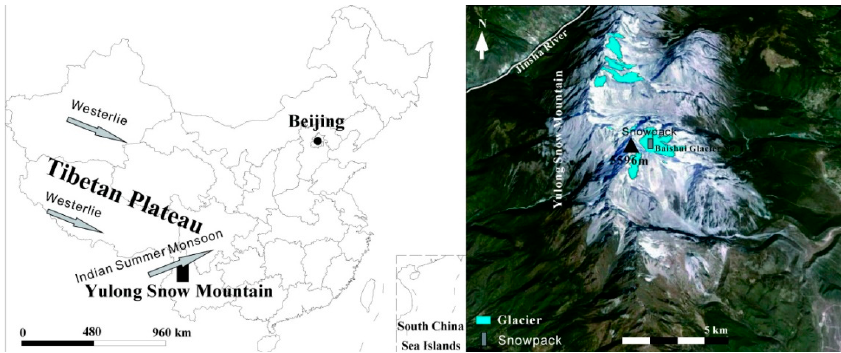
Figure 1. Location of the snowpack of the Baishui Glacier No. 1 in Mt. Yulong.